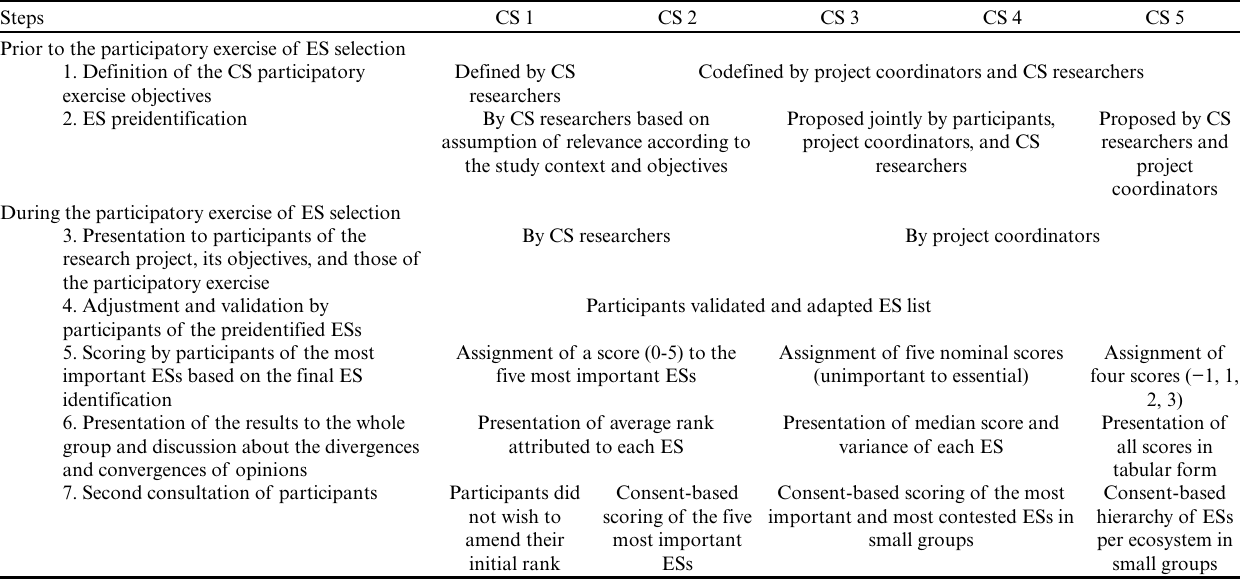
Table 2 . Steps followed by the five case studies for their participatory ecosystem service (ES) identification and selection. After defining the objective (step 1), the five case studies (CSs) carried out an ES preidentification (step 2), which was (re-)submitted to participants during the participatory exercise of ES selection for adjustment and validation (step 4). Participants were then asked to score ESs based on this commonly defined list (step 5). After a presentation of the outcomes (step 6), a second consultation was carried out to obtain consent (step 7).